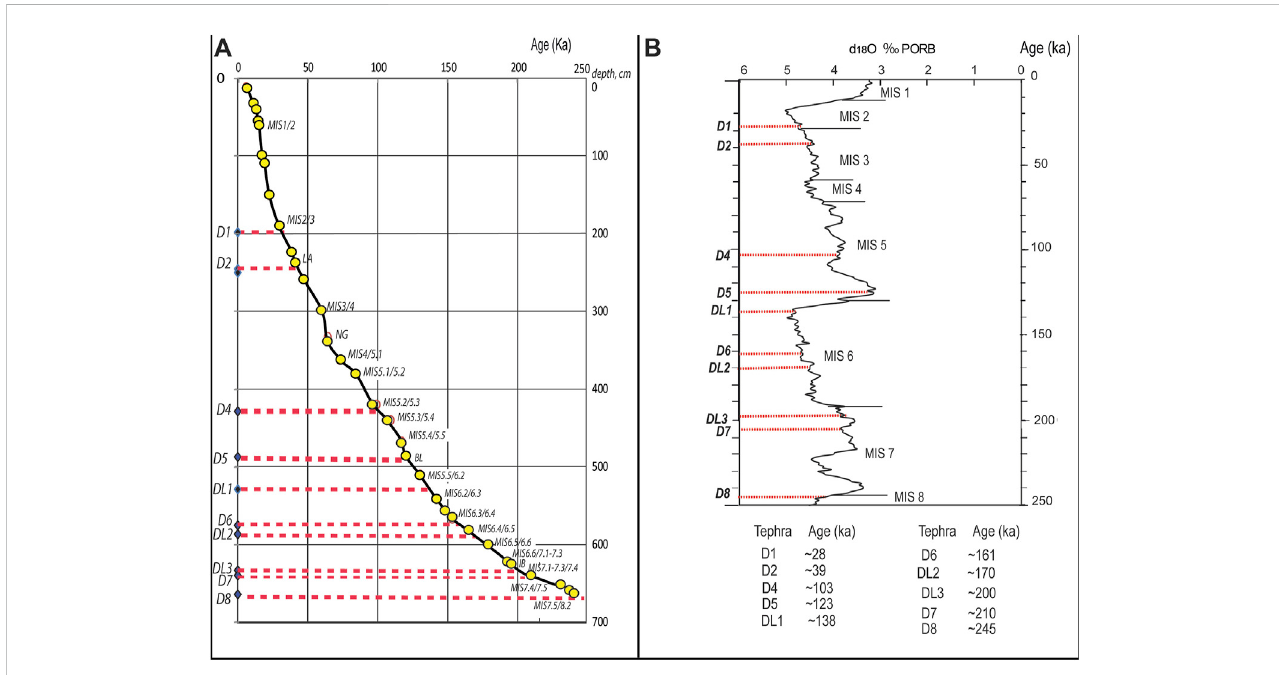
FIGURE 4 Age versus depth plot of sediments from Lv63-4-2 core. (A) Age model for the sediment core. Ages of key tie points are based on the correlation of the troughs in the relative paleointensity (RPI) curves with the dates of the paleomagnetic excursions by Thouveny et al. (2004); Channell et al. (2009). Other key tiepointsarebasedoncorrelationsofthesensitiveclimatelithologicalparameterstrendsofexaminedsedimentstotheMISboundaries(Martinsonetal.,1987; Lisiecki and Raymo, 2005; Wang et al., 2008). The inset shows the main established age markers (see Figure 3; Table 1). Red-dashed lines show the positionofthetephralayers andlenses. (B) Tephrostratigraphic schemeofsedimentfromcore Lv63-4-2. The isotopecurveisgivenaccordingtoLisiecki and Raymo, 2005. The ages of the tephra layers are given according to our age model (see Figures 3, 4A; Table 1) at the bottom of the fi